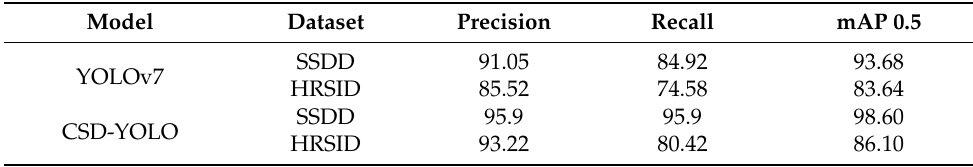
Table 3. Recognition performance of the two models on different datasets.